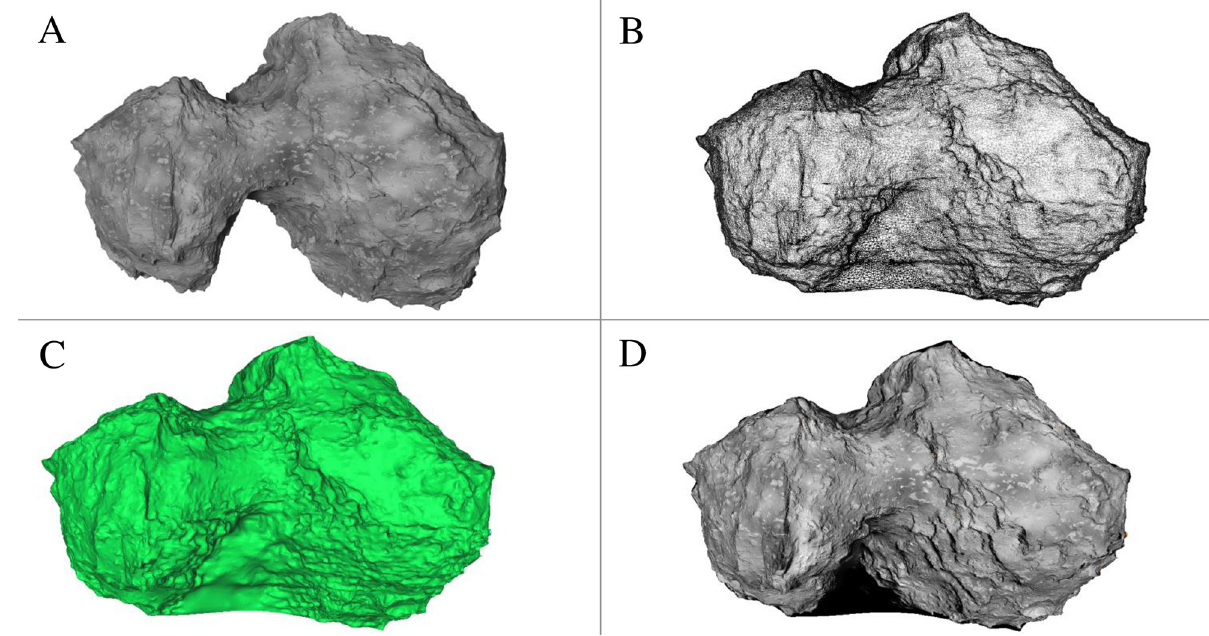
Fig 14. Final reconstruction of the visible part of the target without post-production. (A) Synthetically generated image (input). (B) Vertices of reconstruction. (C) Mesh with normals. (D) Triangular mesh with texture.